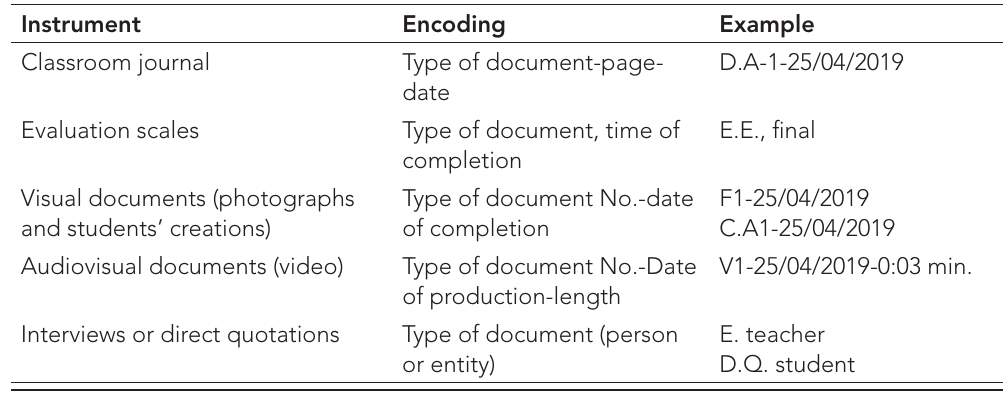
Table 1: Data encoding